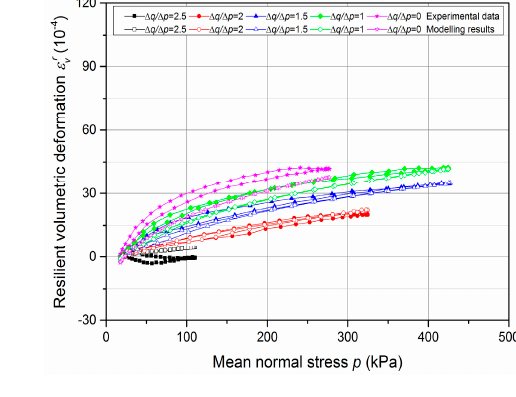
Table 6. Parameter optimization of Equations(12)–(15) for UGM Bréfauchet with γ 3 .